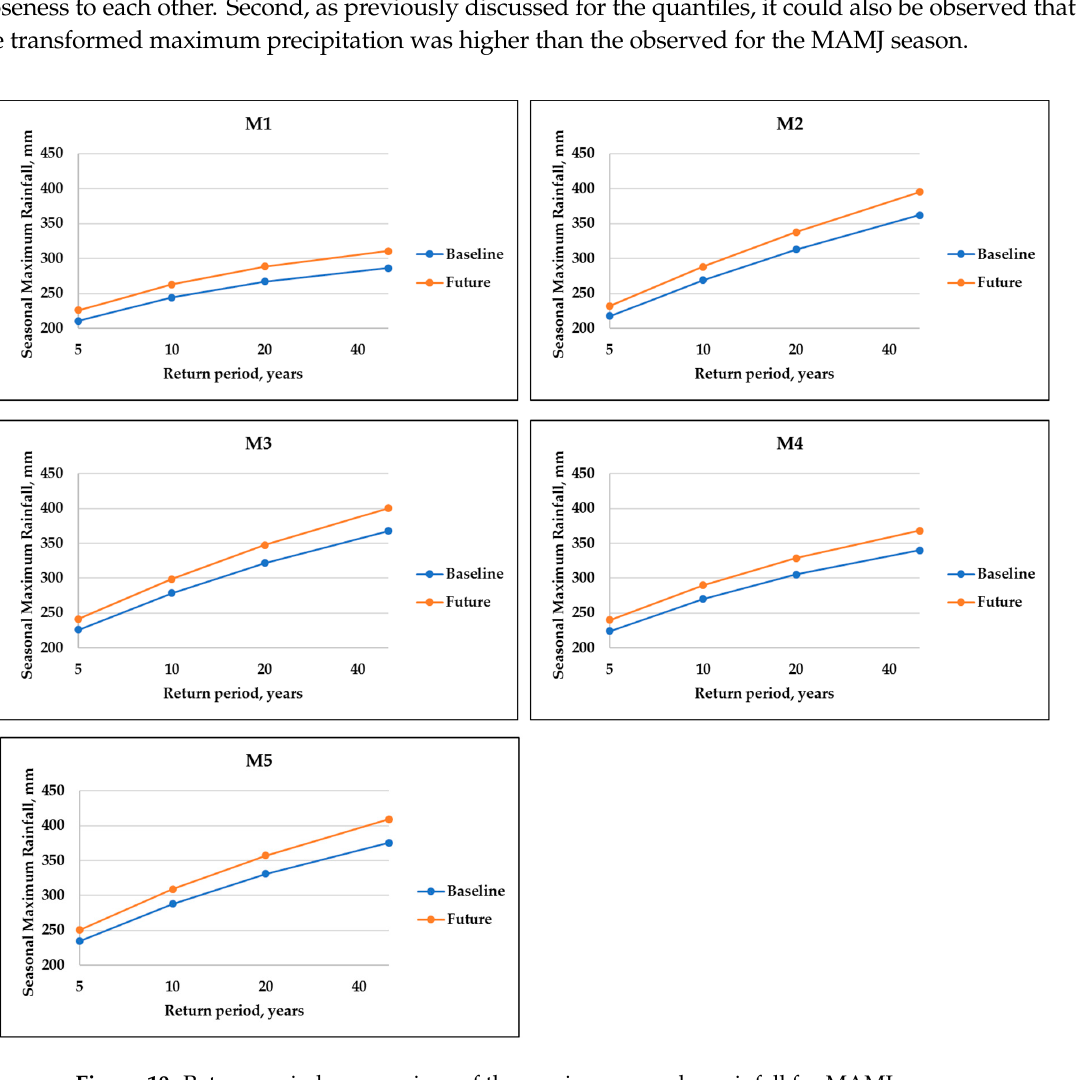
Figure 10 . Return periods comparison of the maximum one day rainfall for MAMJ season . Figure 10. Return periods comparison of the maximum one day rainfall for MAMJ